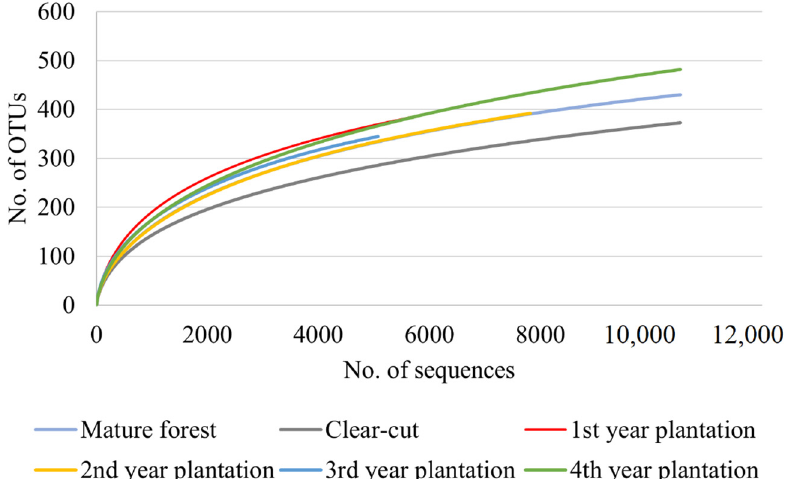
Figure 3. Rarefaction curves showing the relationship between the cumulative number of fungal operational taxonomic units (OTUs) and the number of internal transcribed spacer (ITS) rRNA sequences from corresponding sampling sites; the data obtained in the three study sites (A, L, and V) were combined to give a generalized trend for the mature forest stands, clear-cuts, and reforested 1st–4th year Pinus sylvestris L. plantations.